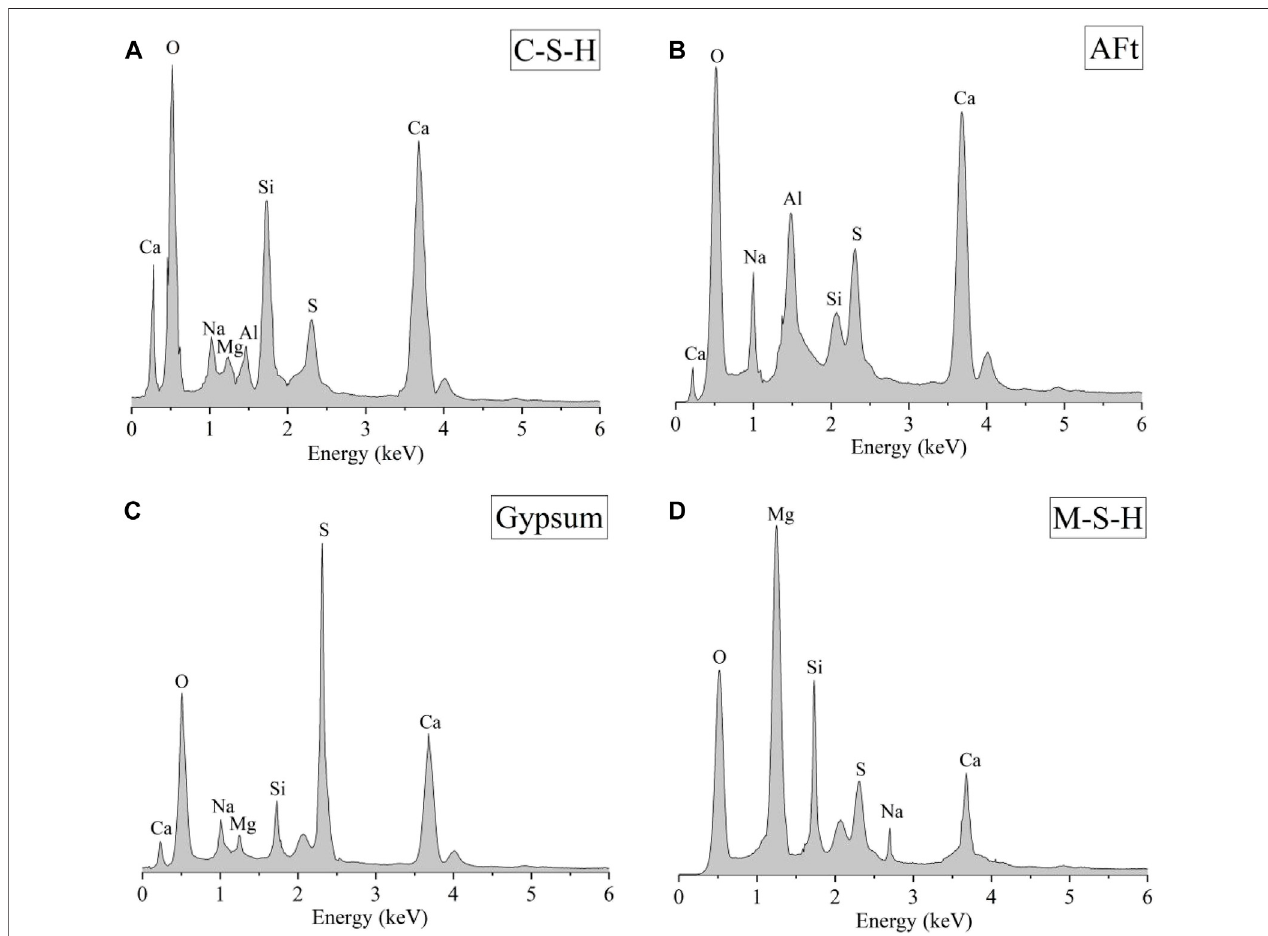
FIGURE 8 | EDS spectrum when the number of cycles is 120: (A) C-S-H; (B) AFt; (C) Gypsum; (D) M-S-H.